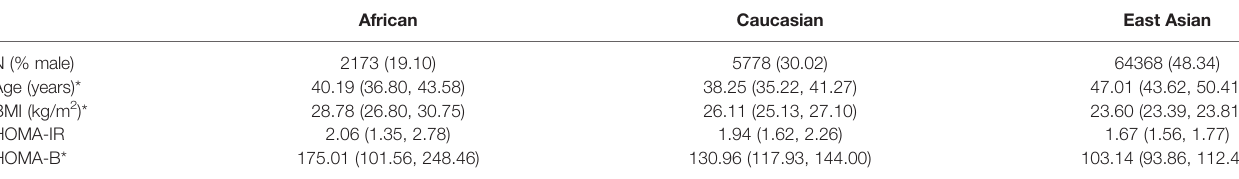
TABLE 1 | Ethnic characteristics of pooled data in NGT population. African Caucasian East